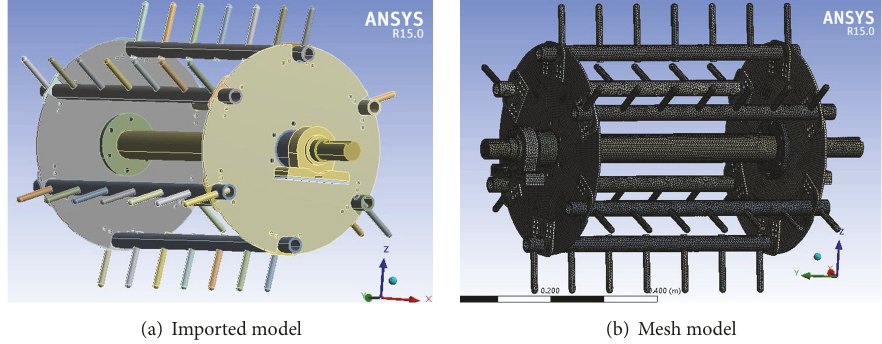
Figure 5: Analysis model of tangential threshing cylinder.